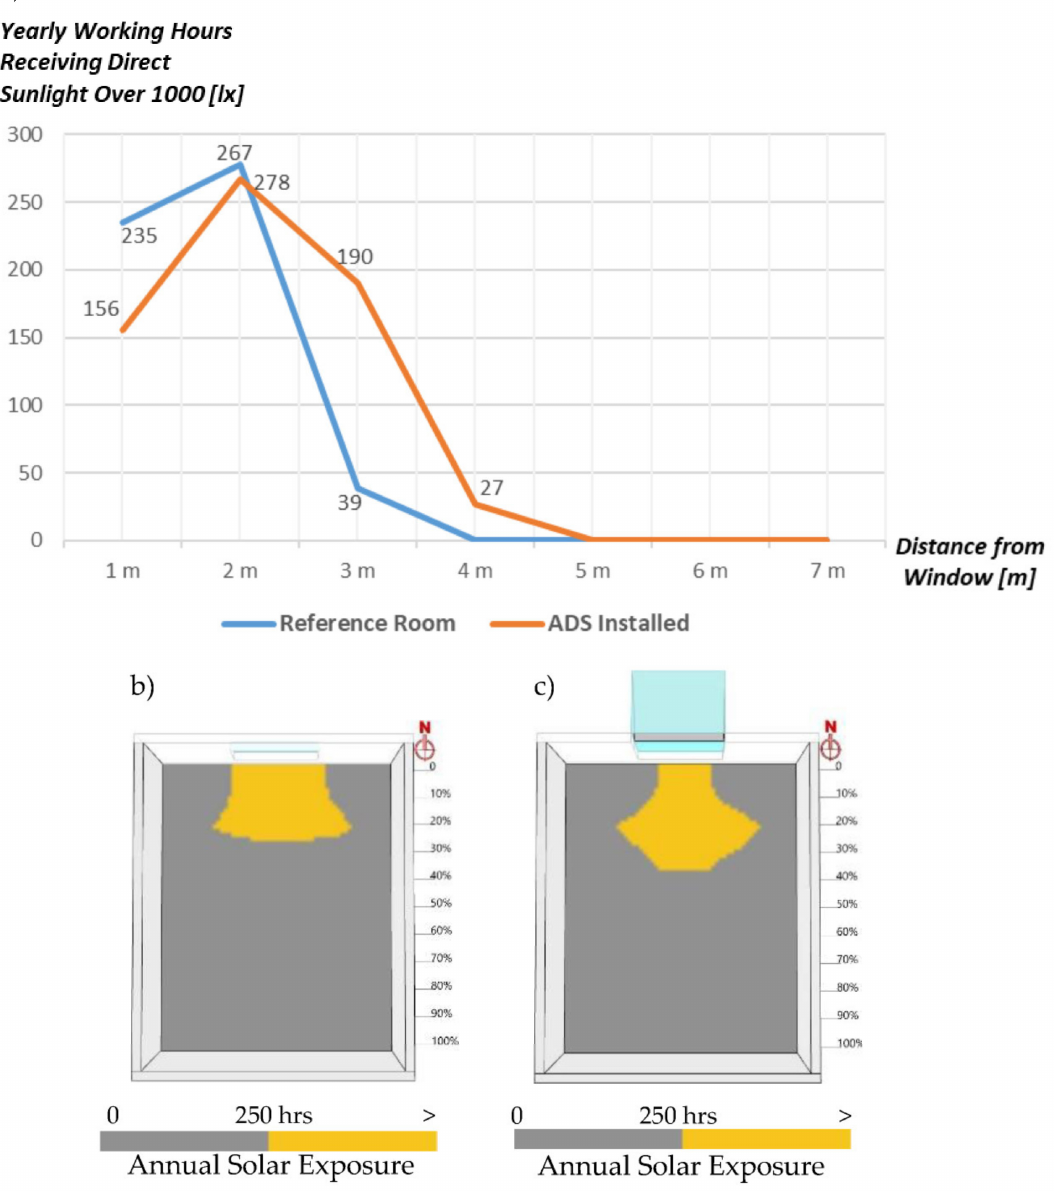
Figure 11. The effect of the ADS on ASE: ( a ) Comparison; ( b ) Reference room; and ( c ) ADS- installed